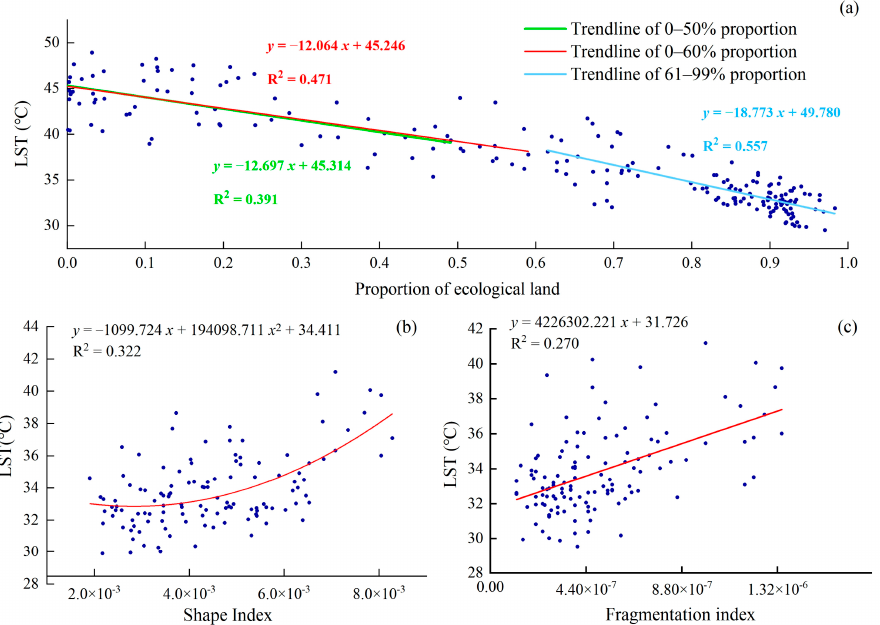
Figure 3. Analysis of the effects of 3 landscape composition factors (proportion, shape, or fragmentation) on LST: ( a ) A segmented linear regression method was used to fit the ecological land proportion with LST in steps of 10% to determine the ecological land threshold with the most significant cooling effect. ( b ) Fitting results of shape index and land surface temperature. ( c ) Fitting results of fragmentation index and land surface temperature.